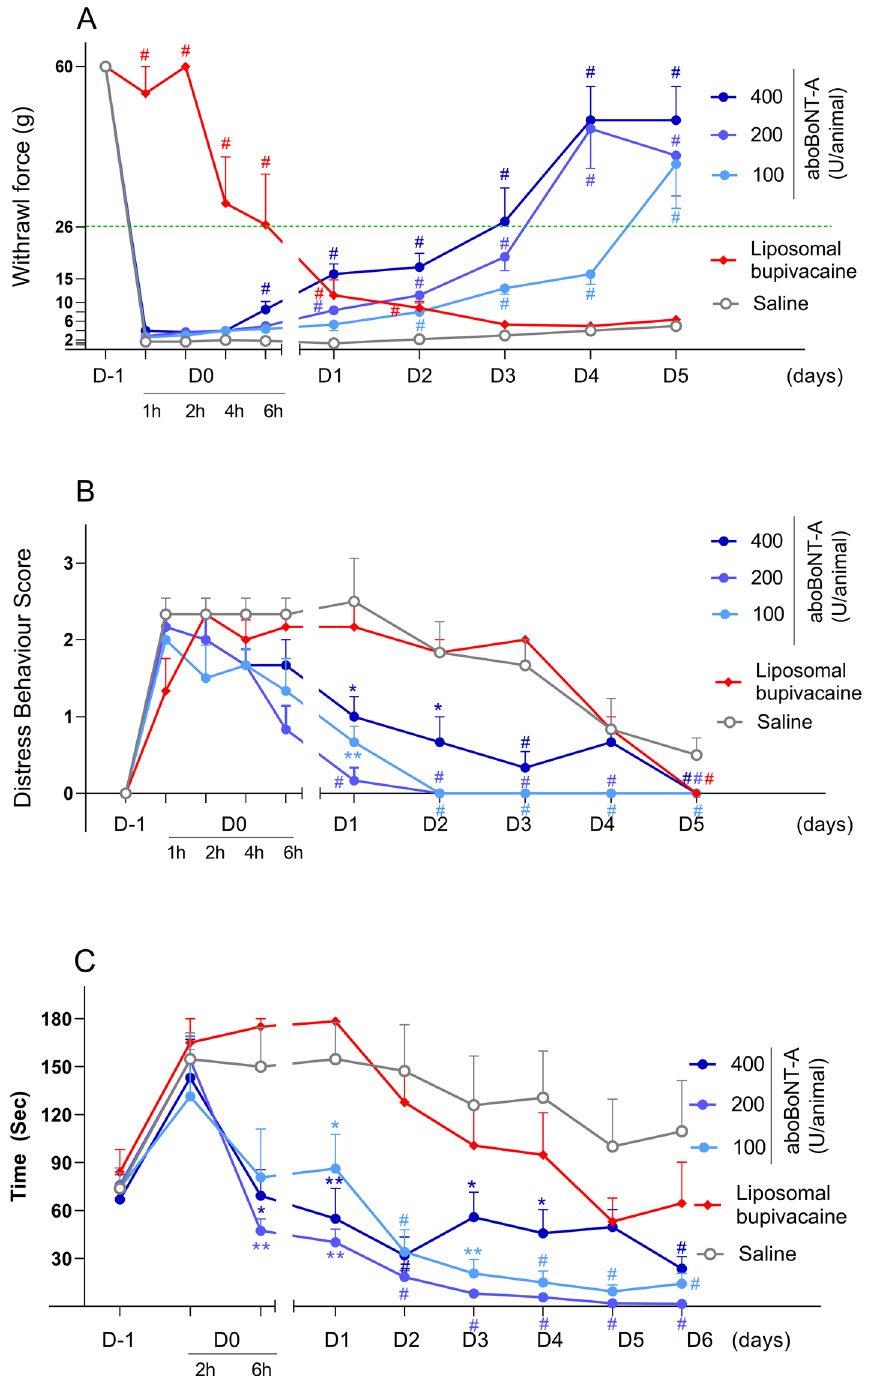
Figure 1. Effects of aboBoNT-A, saline, and liposomal bupivacaine on postsurgical pain-related behavioral responses in pigs. Mechanical sensitivity/withdrawal force (WF; g, A ), DBS ( B ) and approaching time (sec; C ) in animals that received a full-skin and muscle incision and retraction surgery (Day 0), followed by intraoperative treatment with either aboBoNT-A (100 U, 200 U, or 400 U), saline, or liposomal bupivacaine (n = 6/group). The green dotted line in panel ( A ) at 26 g represents the mechanical sensitivity threshold between normal mechanical sensitivity and mechanical hypersensitivity/allodynia. Each point represents the observed mean (± SEM). *p < 0.05, **p < 0.01, # p < 0.001 vs saline-injected animals. AboBoNT-A, abobotulinumtoxinA; DBS, distress behavior score; U, unit; WF, withdrawal